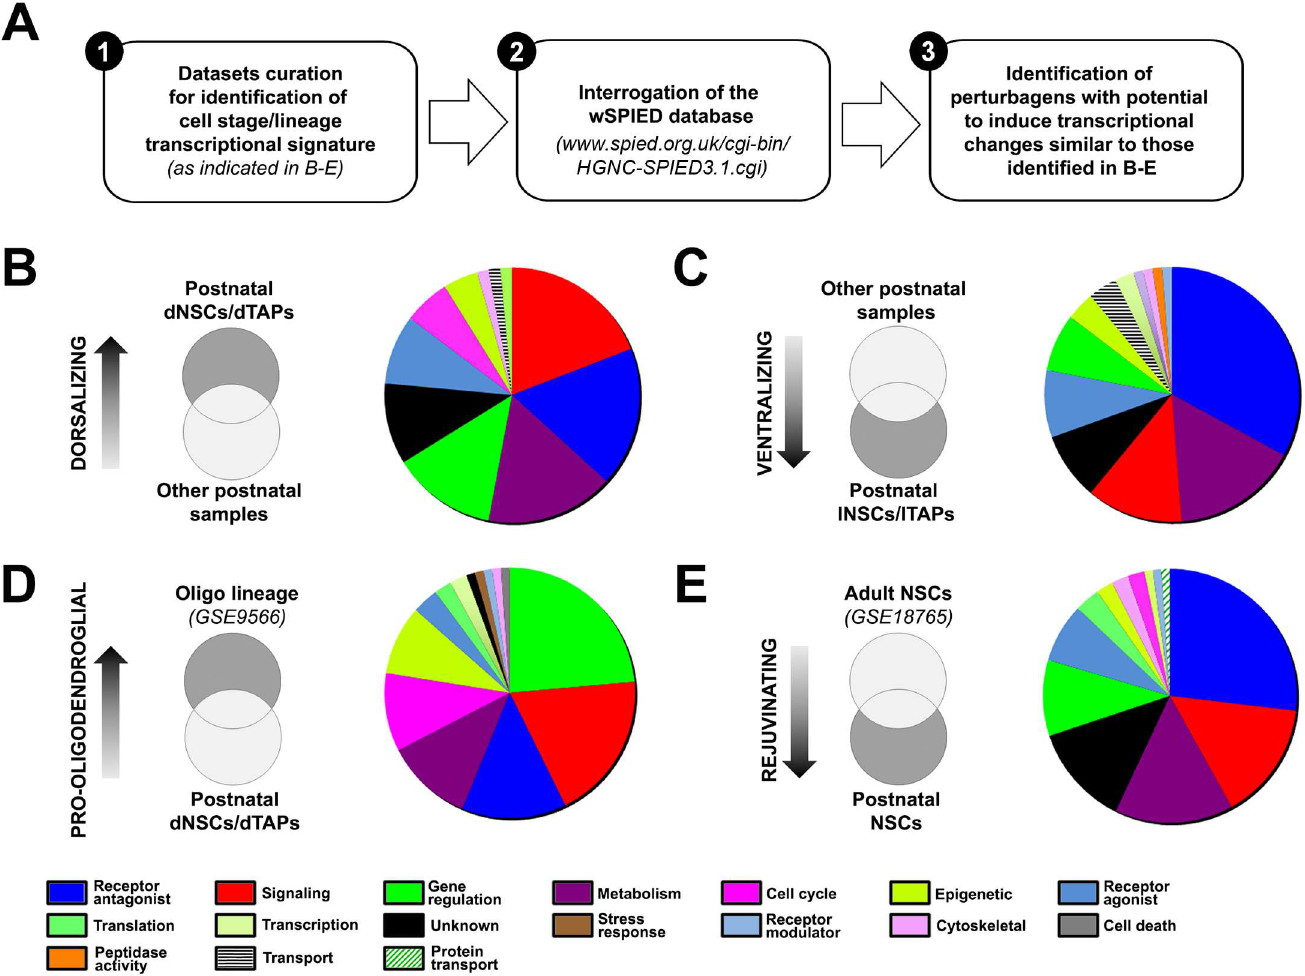
Fig 2. Connectivity map (CMAP) identification of perturbagens that promote region-specific subventricular zone (SVZ) signatures, oligodendrogenesis, and reactivation of adult neural stem cells (NSCs). (A) Schematicrepresentation of the experimental flow. Microarray datasets were comparedfor obtaining expressionsignatures(detailedin Materials and Methods) and uploaded onto searchable platform-independent expressiondatabase(SPIED) to interrogatethe CMAP for obtaininga list of perturbagens. These were further inspectedfor their known protein targets, categorized and presentedin the figure as pie charts (ordered clockwisefollowingtheir ranking order). Note that small moleculesrelated to distinct top- ranked categories are observedin the different analysis. Genes enrichedin (B) dNSCs/dTAPs comparedto other early postnataldatasets (i.e., dorsalization); (C) lNSCs/lTAPs comparedto other early postnataldatasets (i.e., ventralization); (D) oligodendrocyte (OL) lineage cells comparedto dNSCs and dTAPs; (E) Postnatal NSCs comparedto adult NSCs. dNSCs, dorsal NSCs; dTAPs, dorsal TAPs; lNSCs, lateral NSCs; lTAPs, lateral